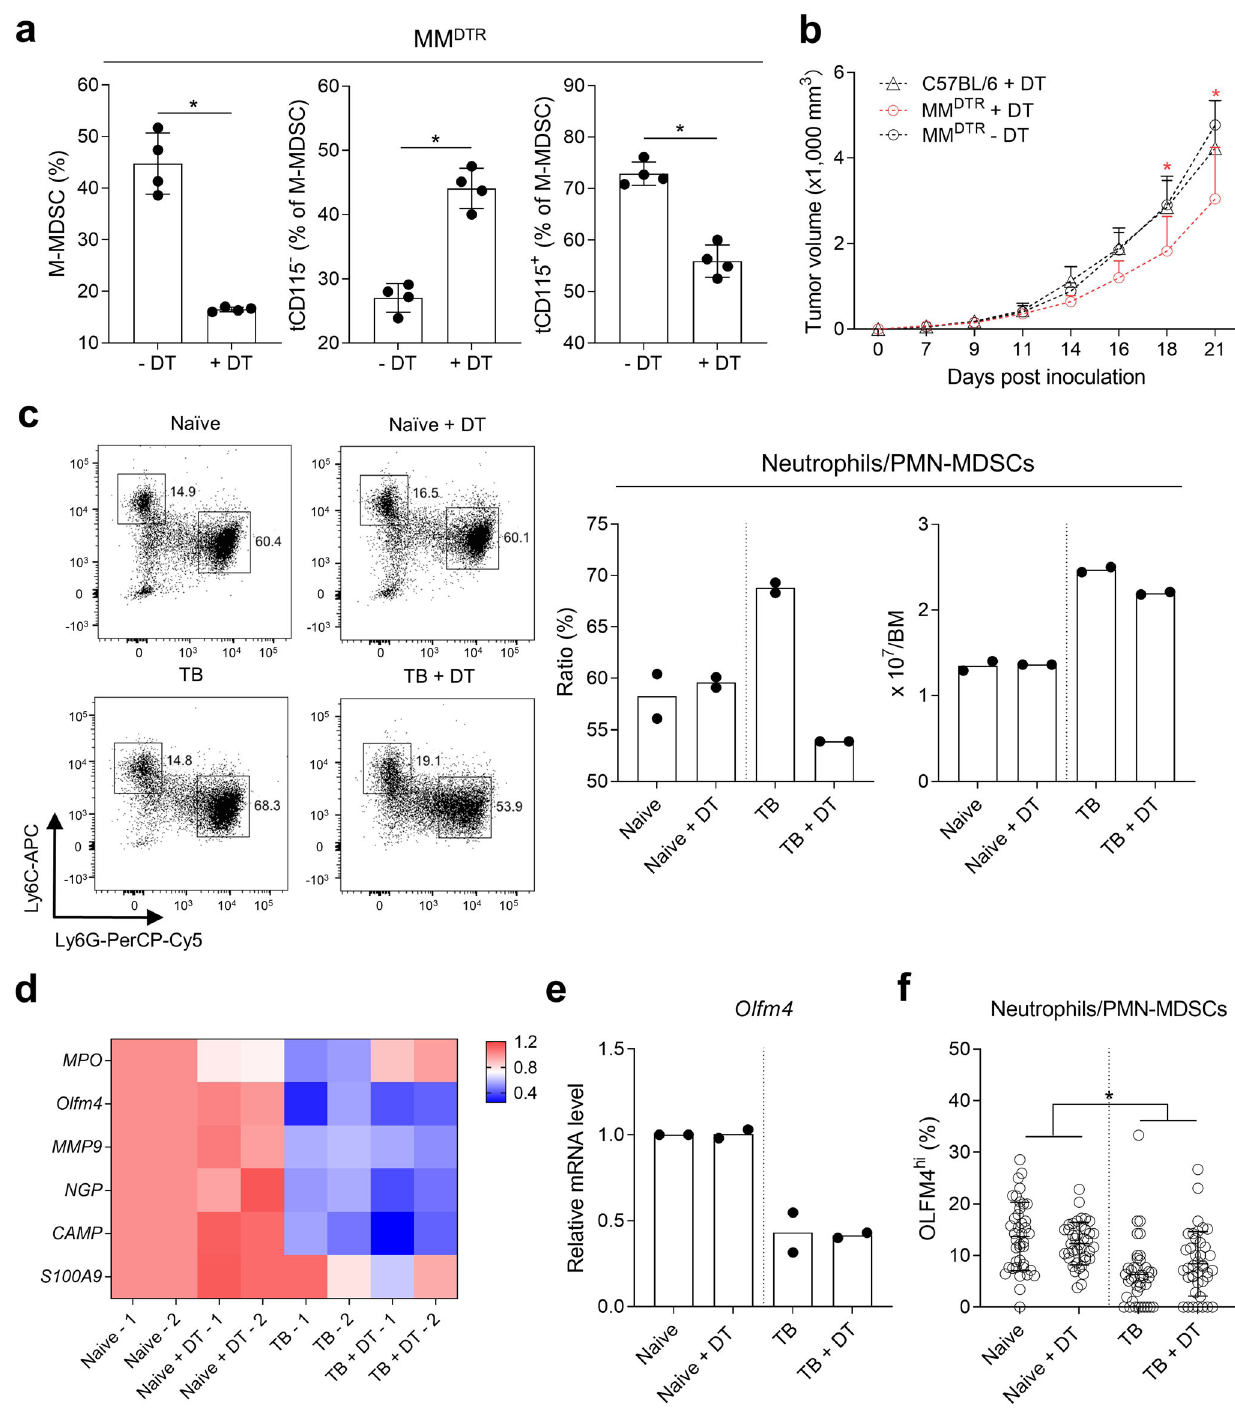
Fig. 6 Depletion of CD115 + M-MDSCs does not affect OLFM4 hi PMN-MDSCs. CD115 + monocytic cells were transiently depleted in MM DTR mice by intraperitoneal injection of DT. a Ratio of M-MDSCs (% CD11c − CD11b + Ly6G − SiglecF − Ly6C hi ) and their subpopulations (CD115 − and CD115 + ) in BM of MM DTR mice with or without DT treatment ( n = 4 per group). b Tumor volume of EL4 TB C57BL/6 and MM DTR mice with or without DT treatment ( n = 7 – 9 per group). c – f BM cells were prepared from indicated mice ( n = 3 per group) and neutrophilic cells (CD11b + Ly6G + Ly6C lo ) were sorted from pooled BM cells. c Representative plots of neutrophilic cells in BM of naive and EL4 TB MM DTR mice with or without DT injection. Ratio and absolute numbers of neutrophilic cells in BM of naive and EL4 TB mice with or without DT injection are shown in graphs. Data shown are from two biological replicates of each group. d , e Heatmap of neutrophil-associated gene expression ( d ) and Olfm4 expression ( e ) in sorted neutrophilic cells from indicated mice. Data shown are from two biological replicates of each group. f IHC assessment of ratio of OLFM4 hi neutrophilic cells in BM of indicated mice. OLFM4 hi cells were counted from twenty random fi elds. Data pooled from two separate experiments. Statistical comparisons were performed using unpaired Student ’ s t test when only two groups were compared or by Bonferroni ’ s test-corrected ANOVA when more than two groups were compared: * p < 0.05. Data are mean or mean ± SD.